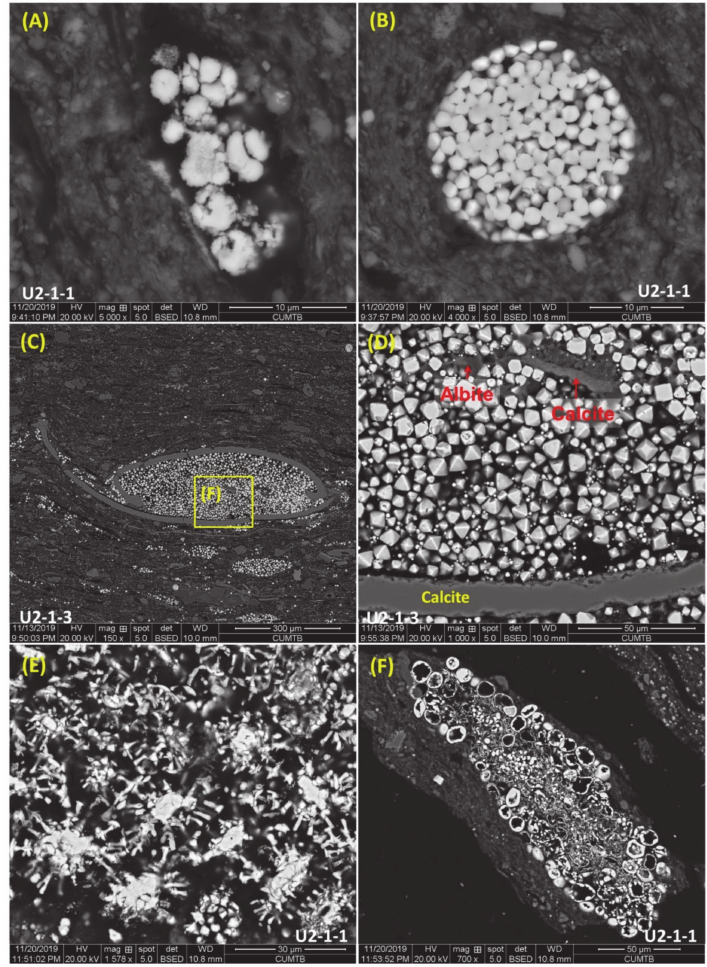
Figure 7. SEM backscattered electrons images of pyrite, as well as calcite and albite, in the oil shales. ( A ) bacterial pyrite framboids; ( B ) individual inorganic framboidal pyrite; ( C ) abundant euhedral pyrite crystals bounded by calcite strips; ( D ) Enlargement of the rectangle in ( C ) showing euhedral pyrite crystals, albite, and calcite; ( E ) dense radial pyrite; ( F ) nodular pyrite